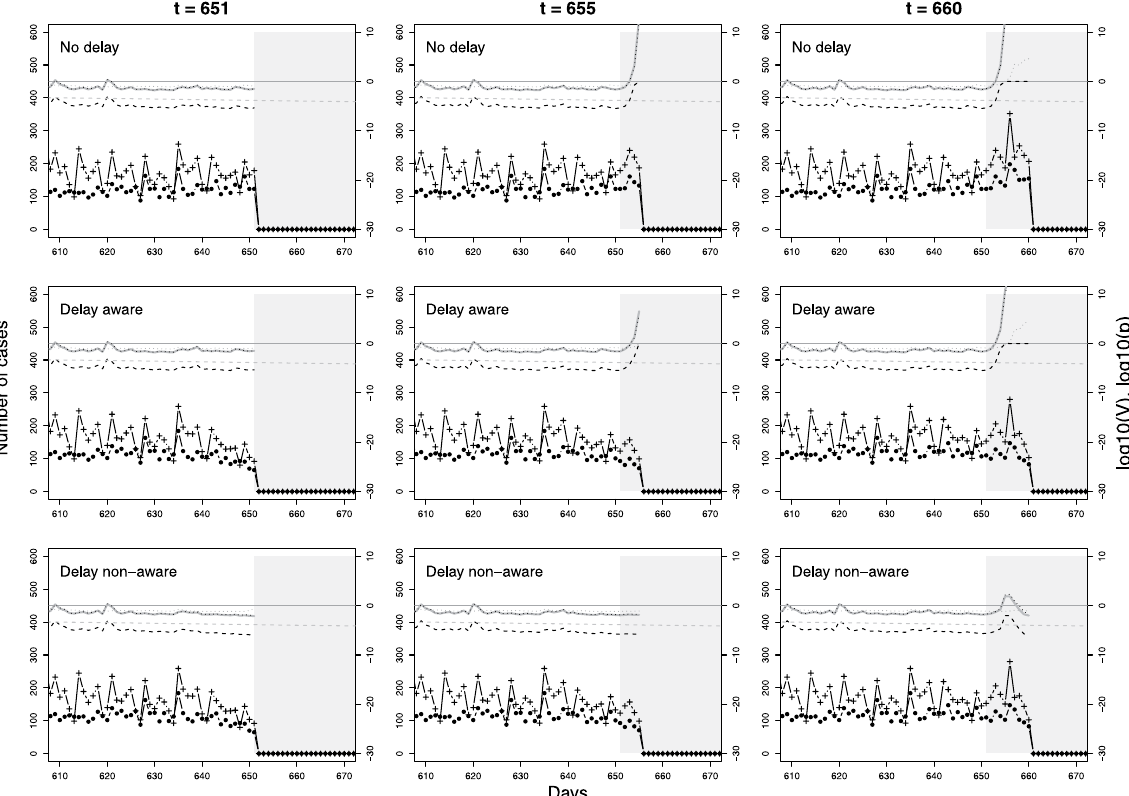
Figure 3. Evolution of the value of evidence at three days of observation (t) in comparison for the three scenarios no delay (top row), delay aware (middle row), and delay non-aware (bottom row). For illustration purposes, results for one specific outbreak, starting on day 651, were selected. Number of observed perinatal (black circles) and on-farm deaths (black pluses), value of evidence for both syndromes (solid grey line) and separately (grey and black dotted lines, respectively), prior probability that an outbreak is ongoing (grey dashed line) and posterior probability that an outbreak is ongoing given the evidence (black dashed line). The grey area represents the outbreak interval from days 651 to 678 while the horizontal grey solid line shows a value of evidence equal to 1, i.e. log10(V) =